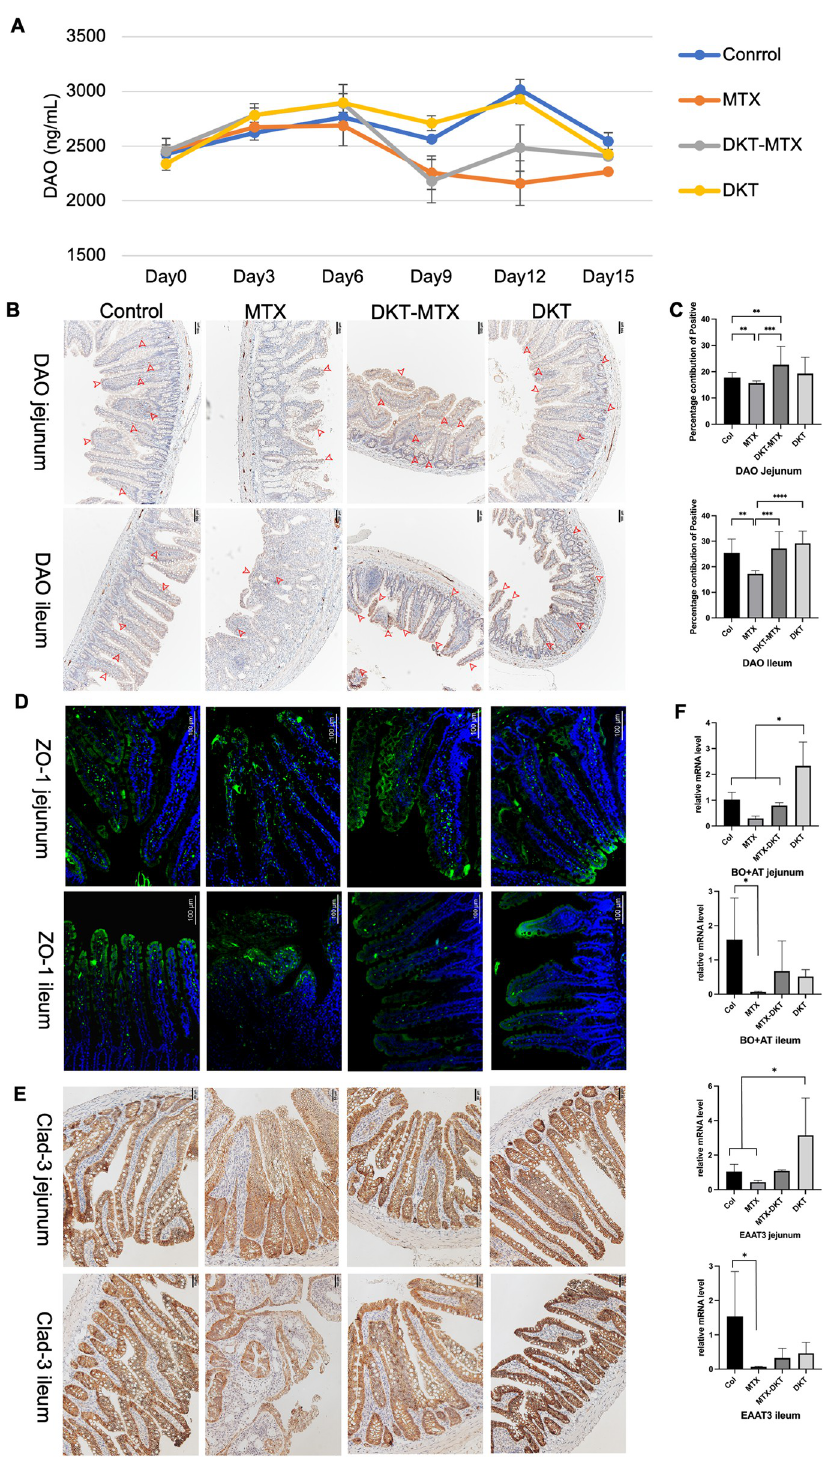
Fig 4. DKT promoted the repair of the mucosal barrier and nutrient absorption functions. (A) The plasma DAO level in the control, MTX, DKT-MTX, and DKT groups. The DAO level decreased in both the MTX and DKT-MTX groups compared with the control group but gradually recovered after day 9 in the DKT-MTX group. Units: ng/ml; DAO, diamine oxidase. (B) Immunohistochemical staining shows the positions and relative level of DAO in the jejunum and ileum of the control, MTX, DKT-MTX, and DKT groups, and (C) the percentage contributions of